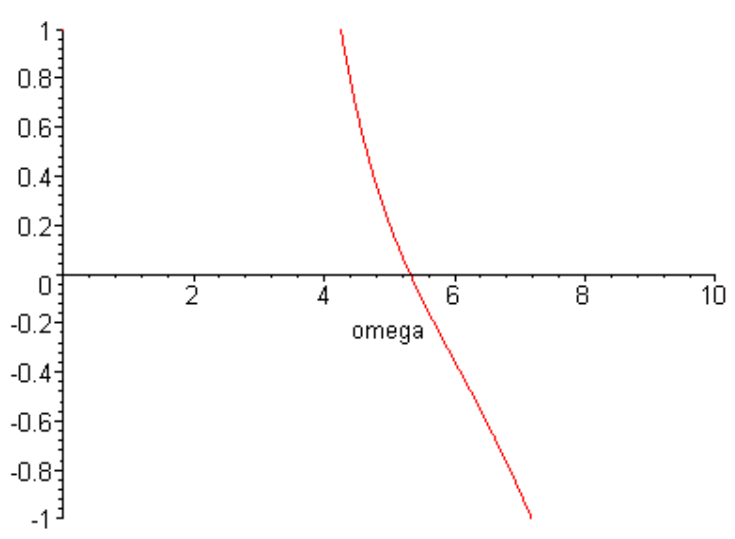
Figure 4. Trend of ω for Ra = 10 4 and A = Figure 4. Trend of (cid:2033) for (cid:1844)(cid:1853) = 10 (cid:2872) and (cid:1827) = 10 .